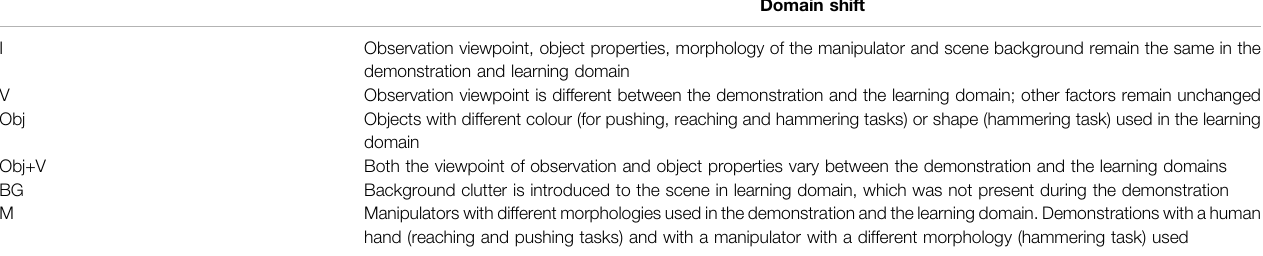
TABLE 4 | Domain shifts used in our experiments.